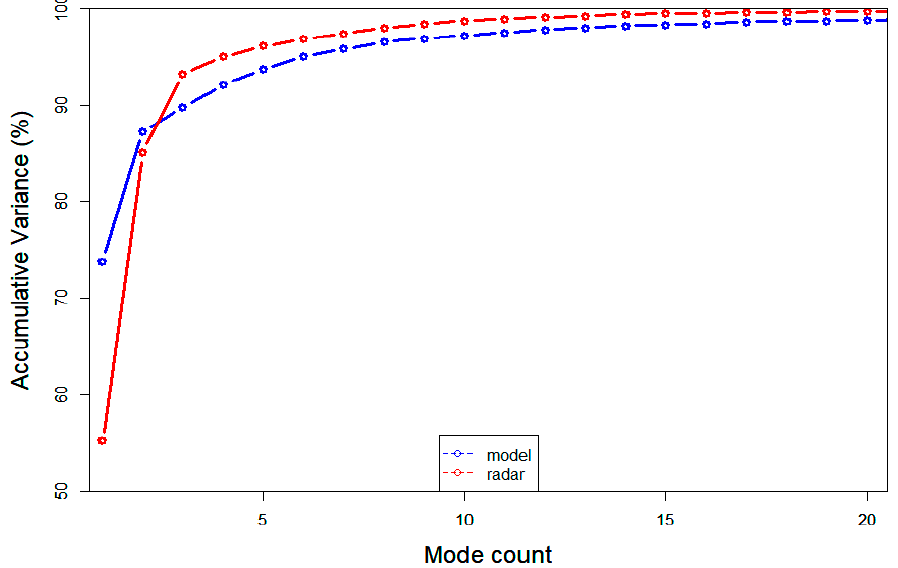
Figure 10. Variance of EOF modes.